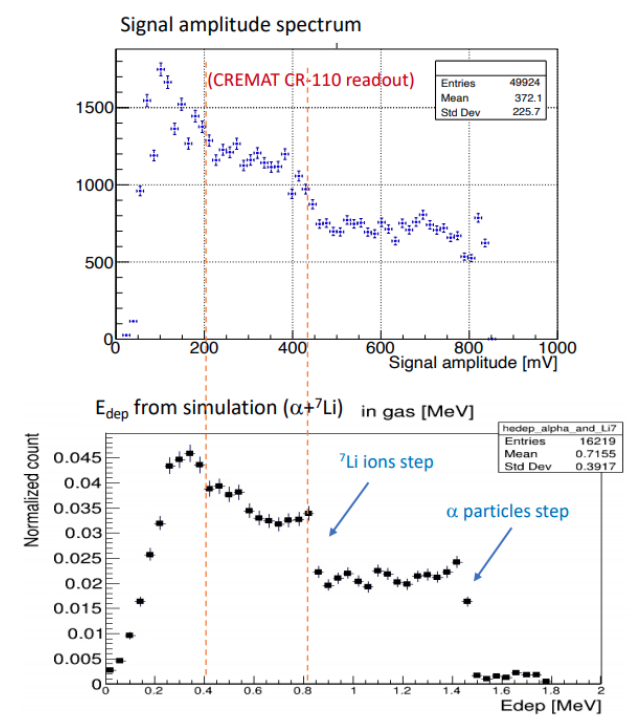
Fig. 7 Signal amplitude spectrum from experimental results (top) and deposited energy from α and 7 Li together from simulations (bottom) are shown. Dotted lines are drawn to connect similar shapes of the two connected quantities. Both plots have been evaluated with the planar cathode